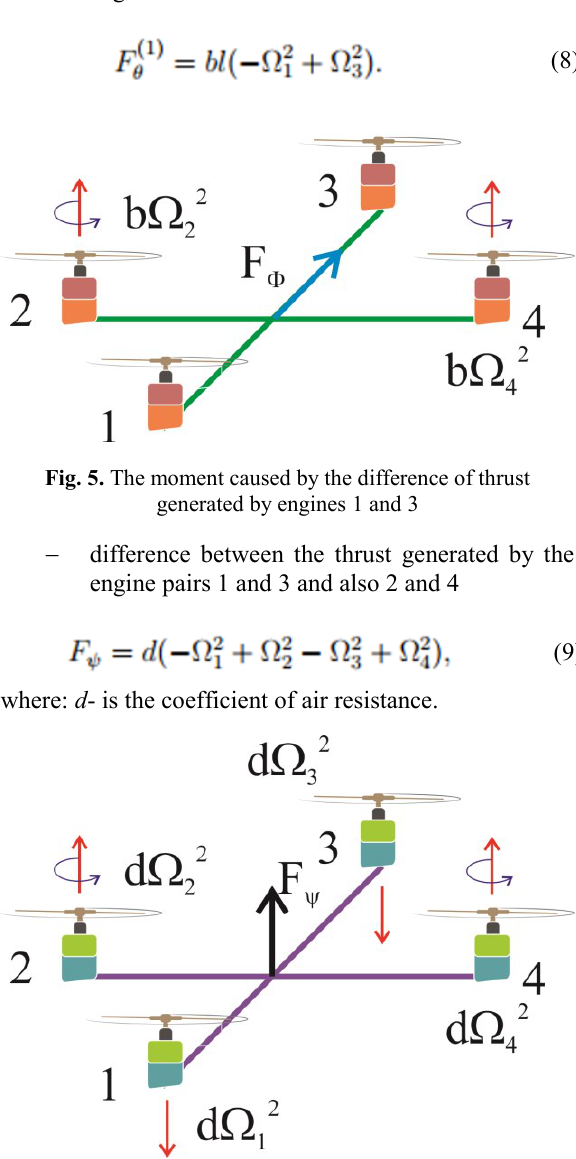
Fig. 6. The moment caused by the difference of thrust generated by the engine pairs